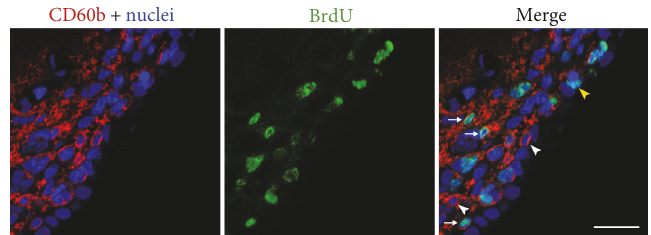
Figure 4: CD60b is expressed in proliferating cells in the rat adult subventricular zone. Confocal image of a coronal section of the lateral ventricle of an adult rat that received intraperitoneal BrdU injections (50 mg/kg) every 2 h for 16h and was euthanized 2h after the last injection. We can observe cells expressing only CD60b (red; arrowheads), cells expressing only BrdU (green, yellow arrowhead), and cells double-labeled for CD60b and BrdU (arrow). Nuclei are counterstained with TO-PRO-3 in blue. Scale bar: 20 μ